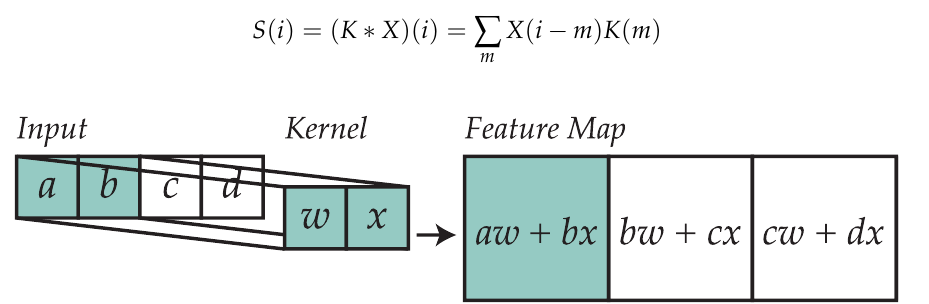
Figure 4. Example of how a kernel is used to convolve the input (extracted from Ref.